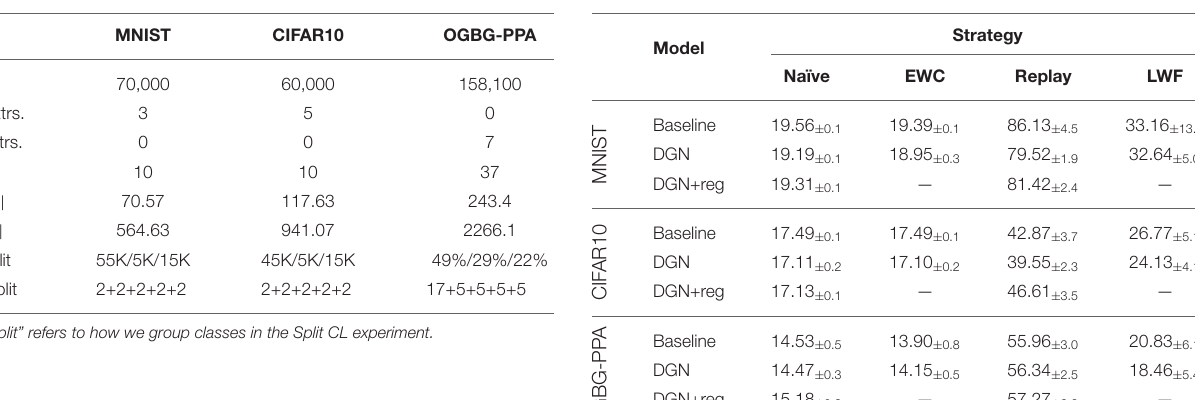
TABLE 1 | Summary of the datasets statistics. TABLE 2 | Mean accuracy and mean standard deviation among all